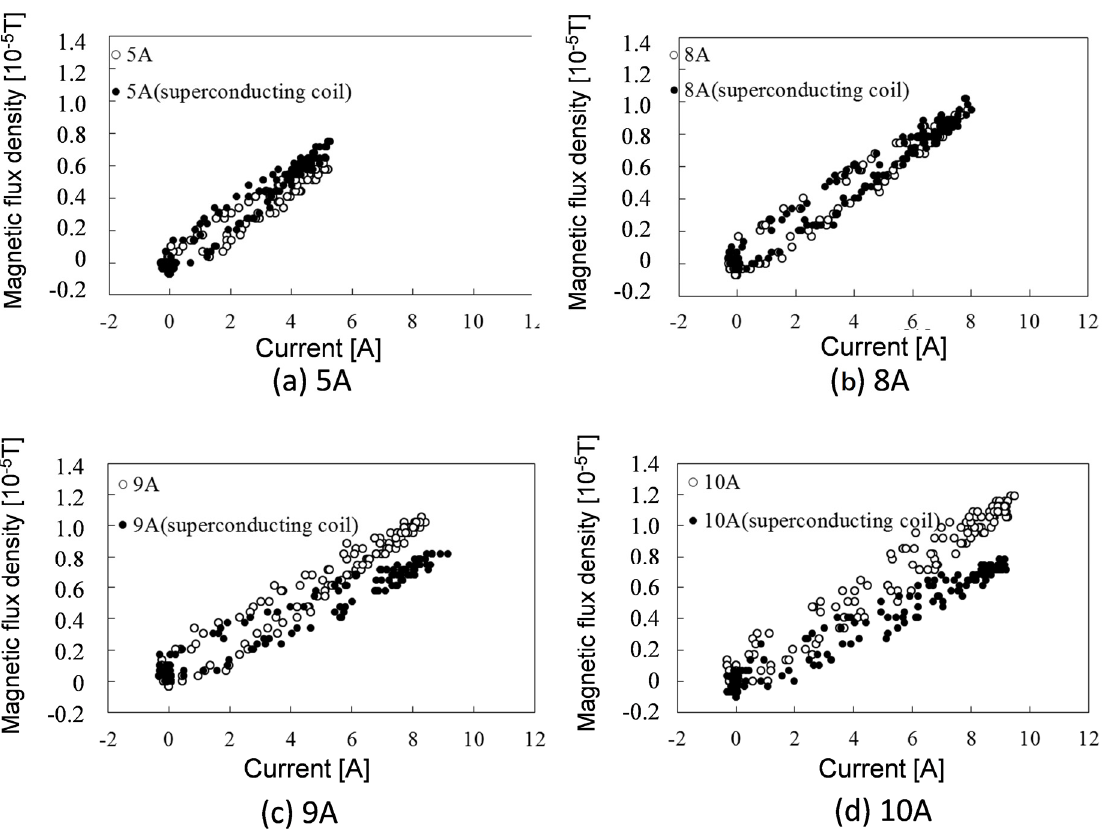
Figure 9. Relationship between magnetic flux density and applied current to two copper coils for various persistent currents of ( a ) 5A, ( b ) 8A, ( c ) 9A and ( d ) 10A.